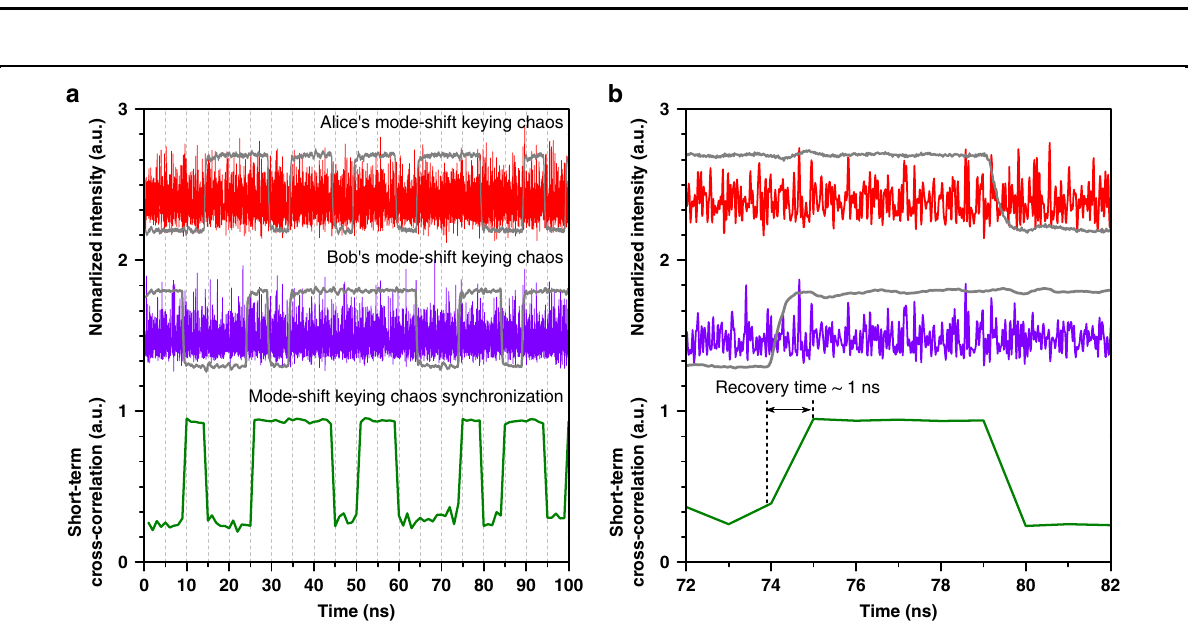
Fig. 4 Experimental mode-shift keying chaos synchronization. a Temporal waveforms of the mode-shift keying chaos as well as the corresponding control sequences of Alice (upper) and Bob (middle), and their sliding short-term cross-correlation (bottom). b The enlarged view of the transition process of synchronization recovery. The correlation length is 1 chaos 30 to implement mode-shift keying for the two FP lasers, respectively. Figure 4 demonstrates typical experi- mental results of the mode-shift keying chaos synchro- nization. The temporal waveforms of the control codes and the corresponding mode-shift keying chaos of Alice and Bob are shown in the upper and the middle parts of Fig. 4a, respectively. The resultant mode-shift keying chaos synchronization is plotted at the bottom of Fig. 4a by the sliding short-term cross-correlation with a corre- lation length of 1 ns. Clearly, the synchronization coef fi - cient reaches around 0.93 when the control codes are the same, but decreases to about 0.25 when the codes are different. In Fig. 4b, an enlarged view of the mode-shift keying chaos synchronization shows that the transition time from non-synchronization to synchronization is ~1 ns. This transition time is determined by the rising